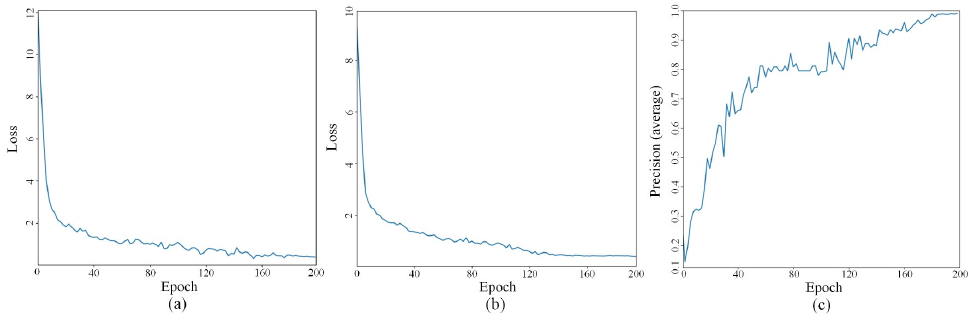
Figure 5. The comparison of transfer learning-based and normal training procedure. Training loss ( a ), evaluation loss ( b ) and average precision ( c ).